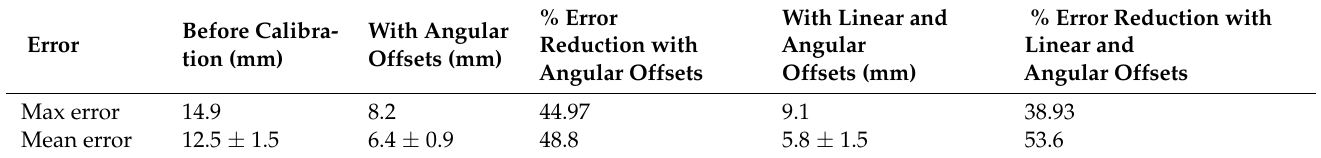
Table 6. Resultant position error before and after calibration.